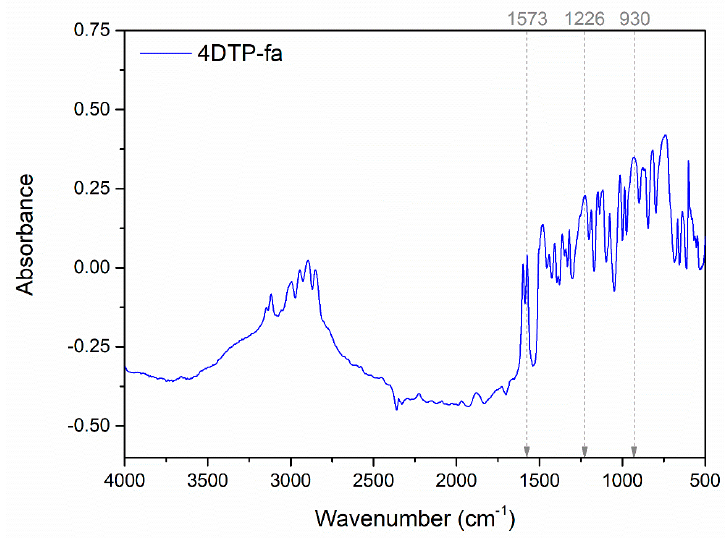
Figure A14. FTIR spectrum of 4DTP-fa.